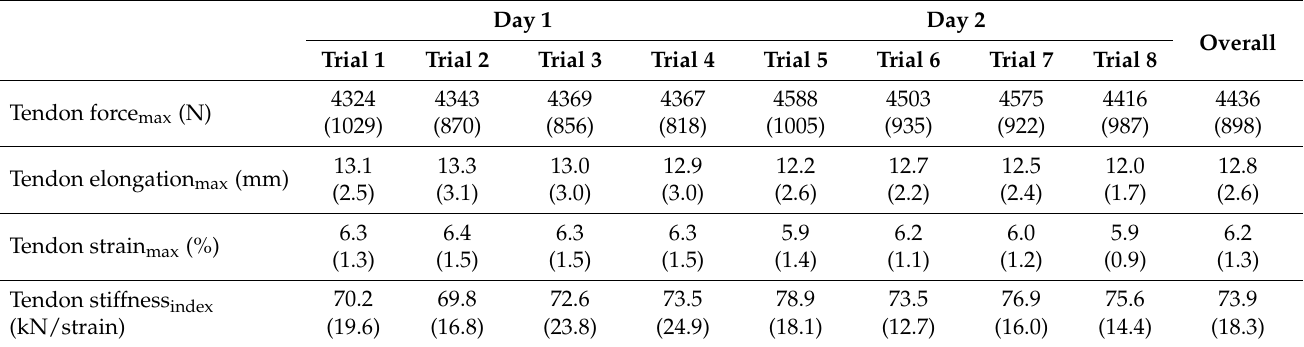
Table 1. Means and (SD) for the analyzed parameters describing the mechanical properties of the Achilles tendon for the eight trials analyzed on day one (Trial 1–Trial 4), day two (Trial 5–Trial 8), and overall (Trial 1–Trial 8).